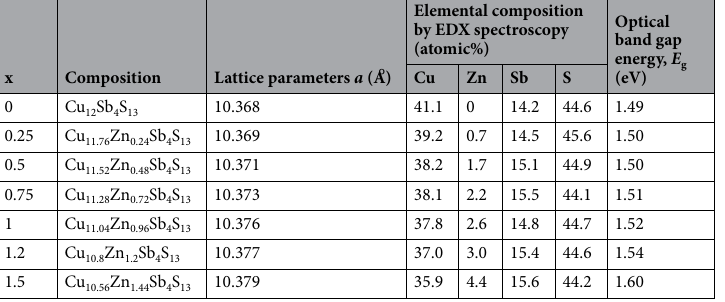
Table 2. Lattice parameter a , EDX compositional analysis and the estimated optical band gap ( E g ) of Cu 12−x Zn x Sb 4 S 13 (x = 0.25, 0.5, 0.75, 1, 1.2, 1.5).